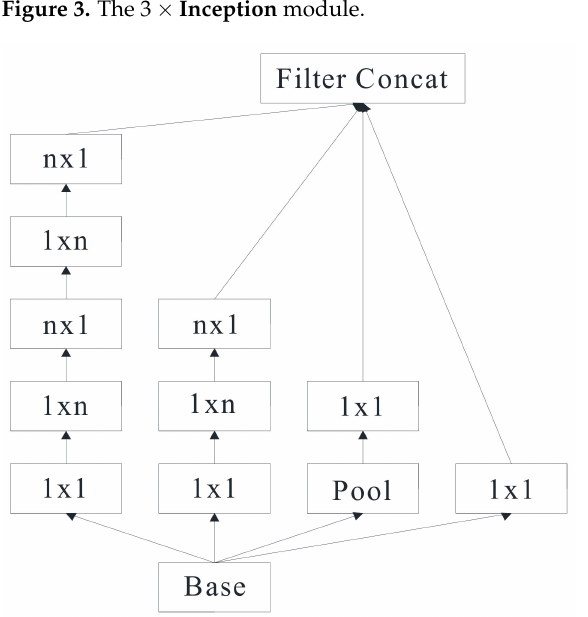
Figure 4. The 5 × Inception